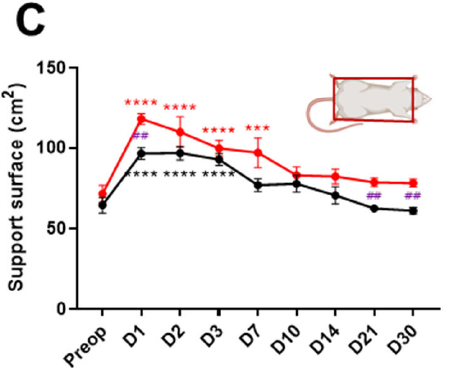
Figure 2. Evaluation of postural and weight distribution of oxytocin-treated animals. ( A ) Assessment of weight distribution on the lateral axis at pre-operative (Preop) time and 30 days post-UVN in UVN-NaCl rats (black n =8) and UVN-OT rats (red n = 7). ( B ) Assessment of weight distribution on the anteroposterior axis at pre-operative (Preop) time and 30 days post-UVN in UVN-NaCl and UVN-OT rats. ( C ) Assessment of the support surface area in UVN-NaCl and UVN-OT rats. Error bars represent standard error of the mean (SEM). * p < 0.05, ** p < 0.01, *** p < 0.001, **** p < 0.0001. A significant difference from the preoperative value is indicated by * in black for the UVN-NaCl group and in red for the UVN-OT group. A significant difference between the UVN-NaCl and UVN-OT rats is indicated by # in purple.